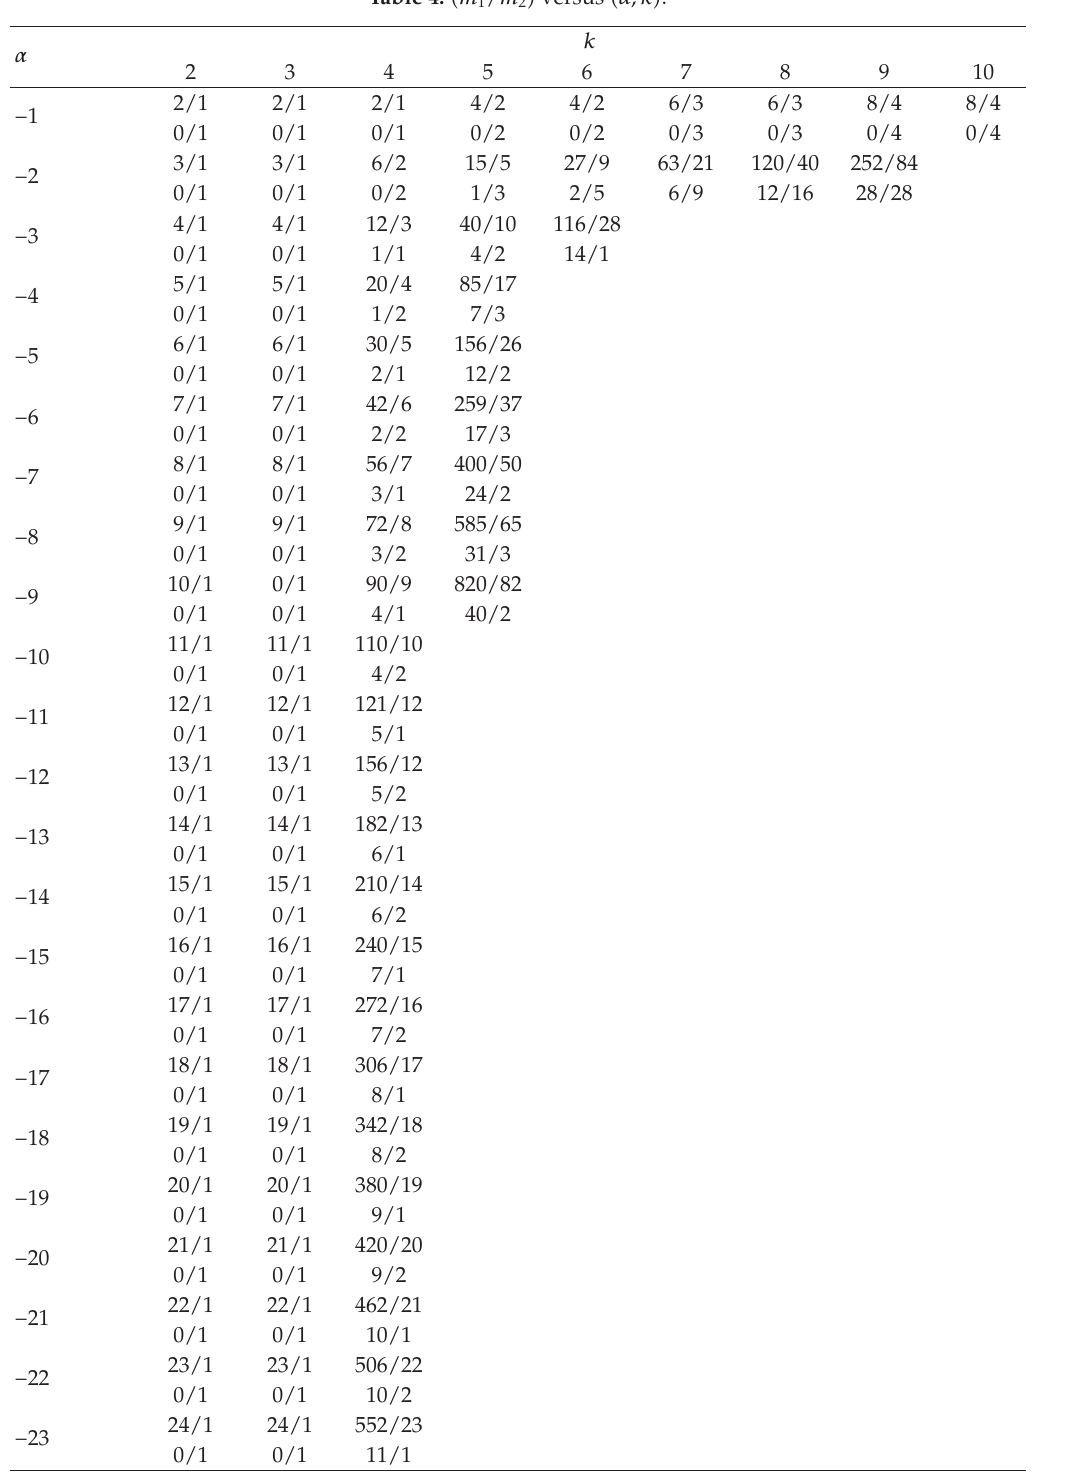
Table 4: (cid:2) m 1 /m 2 (cid:4) versus (cid:2) α,k (cid:4)